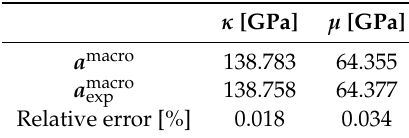
Table 5. Comparison between the identified optimal value a macro and the reference experimental value a macro exp